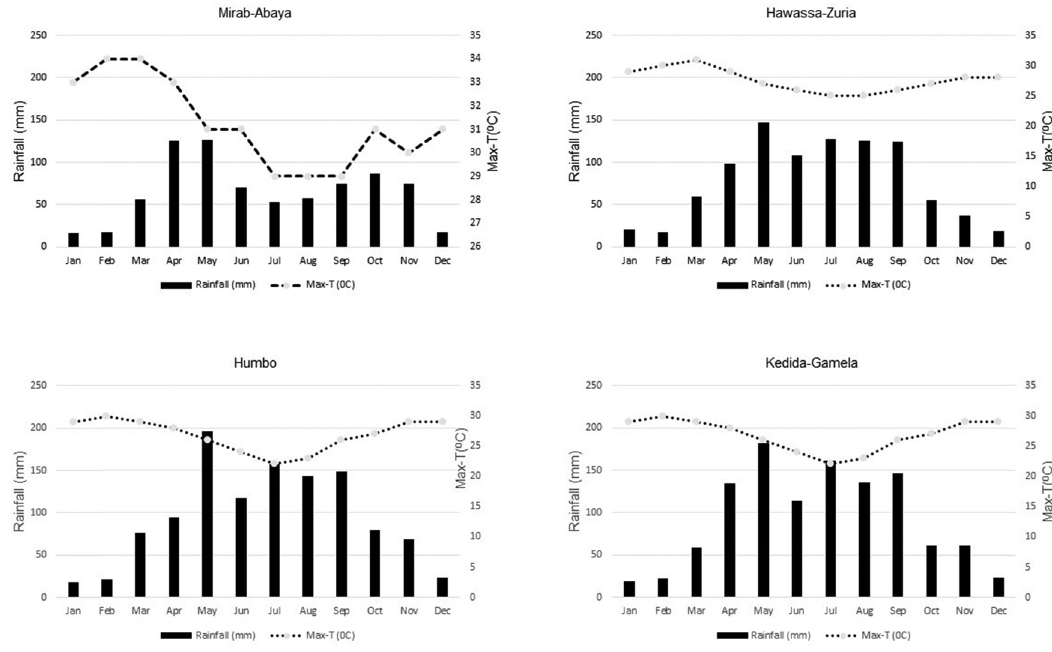
Figure 1: Monthly average maximum temperature and rainfall of the four study areas based on 10 years data ( 2006 – 2015 )